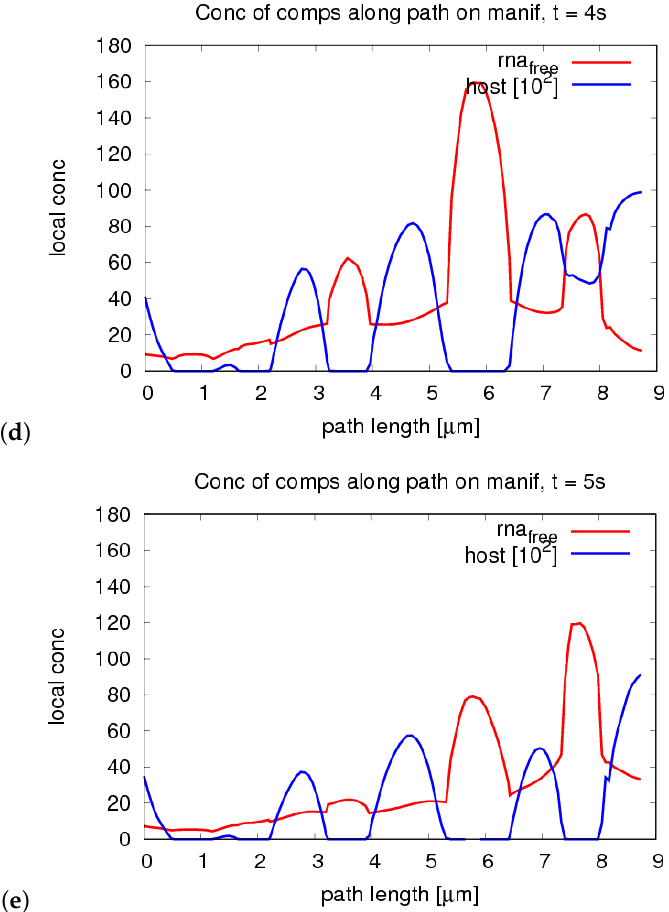
Figure 7. 1D profiles of concentrations along the long path, cf. Figure 2. (For details, cf. Section 3.5.) One sees clearly how the “peak” of free HCV RNA moves through the cell at different time points t = 1,2,3,4,5 s . (( a ): t = 1 s , ( b ): t = 2 s , ( c ): t = 3 s , ( d ): t = 4 s , ( e ): t = 5 s ). Note: The path length seems to be similar on the ER surface between two neighboring webs and from the (spatial) beginning of one webs until its end. However, this is because we cross the webs on their respective longest path “on the top”. The direct distance from the beginning of a web to its end is smaller compared to the distance between two webs. Results of grid refinement level 4. Consider also Figure 9, where we mark the peaks and relate them to their corresponding web